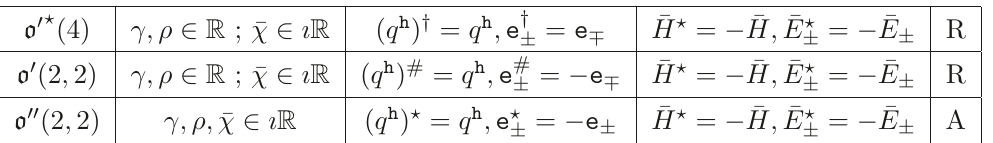
Table 6 . Real quantizations of r V ( γ, ρ, ¯ χ ) = γ E + ∧ E − + ¯ χ ¯ E + ∧ ¯ H + ρH ∧ ¯ E +